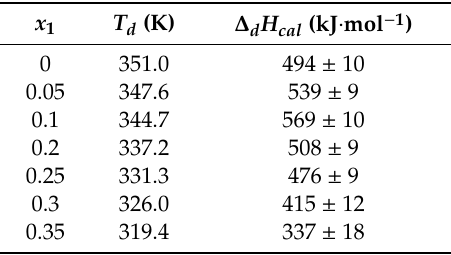
Figure 1. DSC curves of denaturation of lysozyme in DMSO-water mixtures and pure water at a 1 K · min − 1 heating rate. Table 1. The temperatures T d of the lysozyme denaturation peak maximum and the enthalpies ∆ d Hcal of denaturation of lysozyme (per mole of protein) in the mixtures of DMSO with water (mole fraction